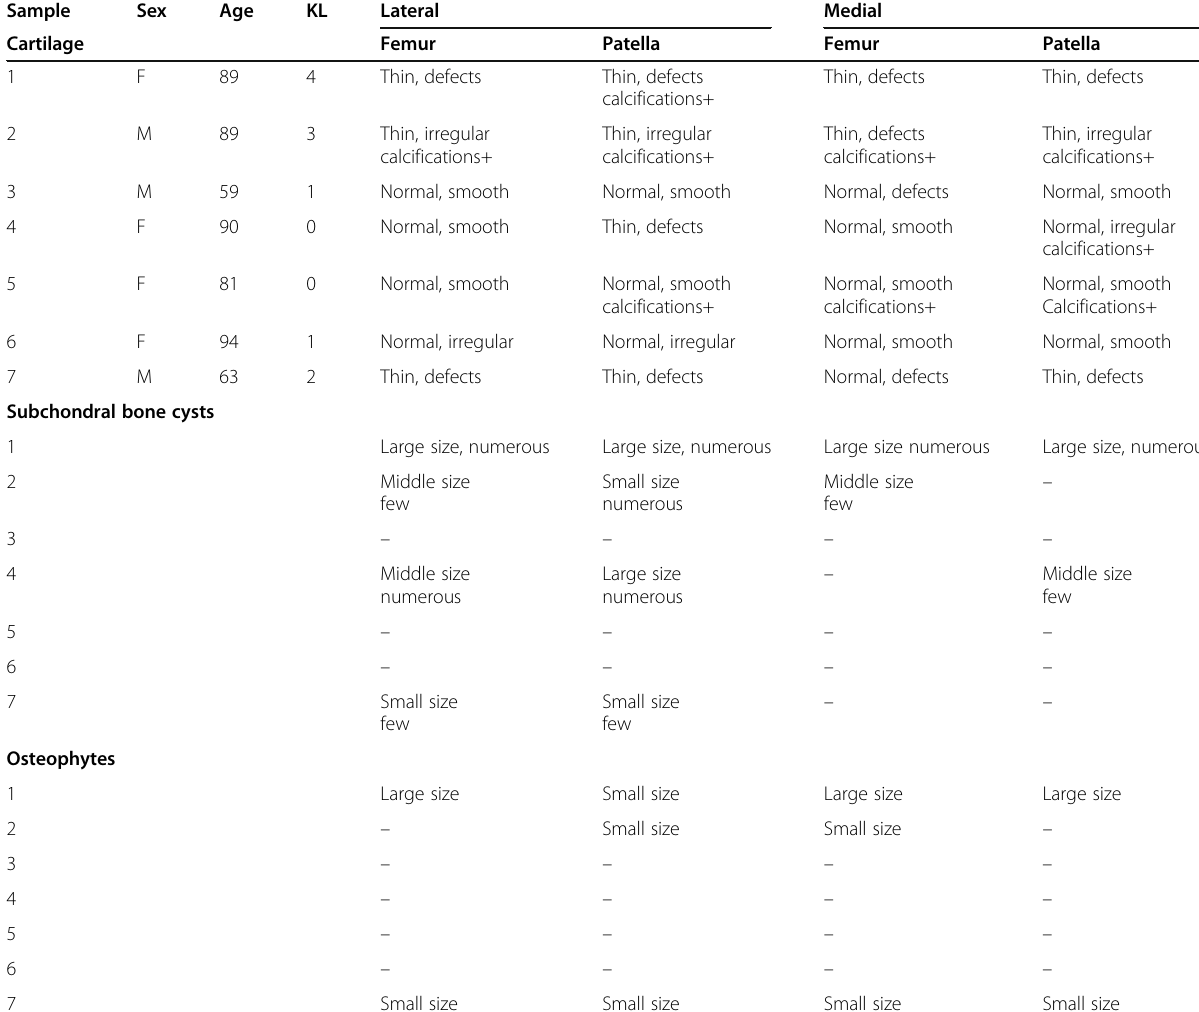
Table 1 Clinical descriptions of the knee specimens in terms of cartilage, osteophytes, and bone cyts